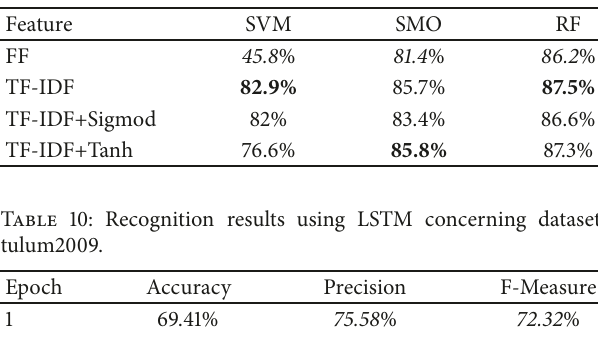
Table 9: Recognition F-Measures using three classifiers concerning dataset cairo.